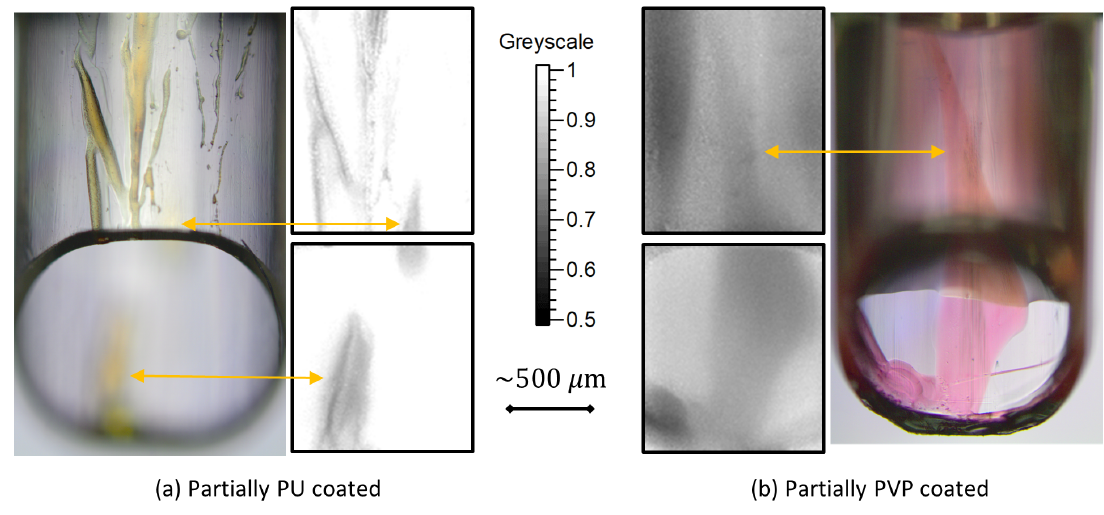
Figure 5. Nozzles partially coated with PU ( a ) and PVP ( b ). For ( b ), the nozzle was coated with PU beforehand using the standard industrial treatment. The U16 greyscale images represent transmission of the coating measured using the IR transmission microscope. Absorption and scattering effects of the bulk PP are not present in the greyscale images. The dye stain images were recorded using a × 5